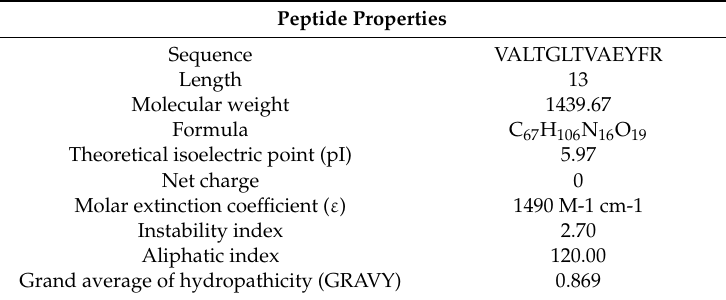
Table 2. Sarconesin II’s theoretical physicochemical properties.